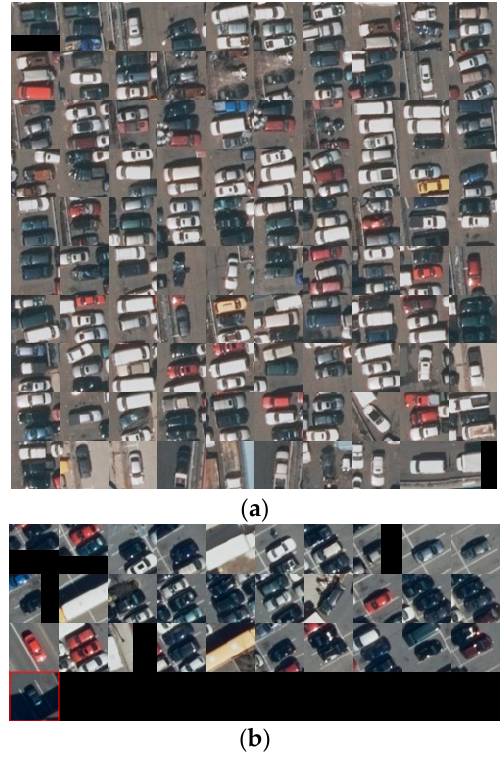
Figure A1. Visualization of undetected vehicle patches. ( a ) Undetected vehicles in test_1 image; ( b ) undetected vehicles in test_2 image. The red rectangle patch is covered by a shadow.